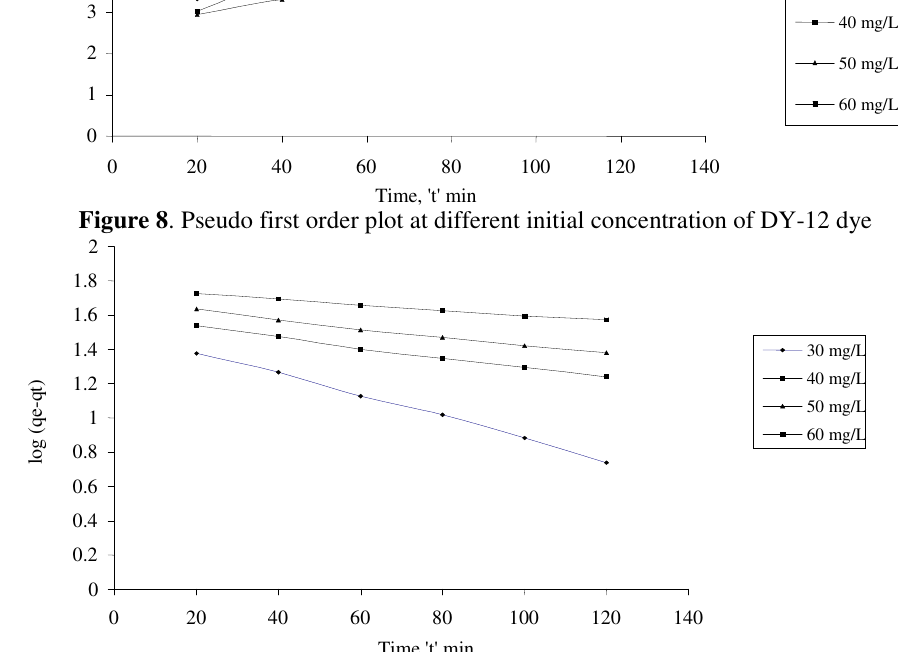
Fig.9. Pseudo-second order plot at different initial concentration of DY-12